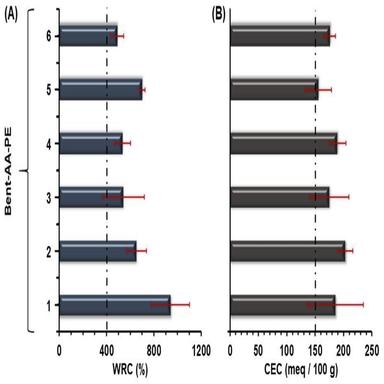
WRC (A) and CEC (B) of Bent-AA-PE composites.